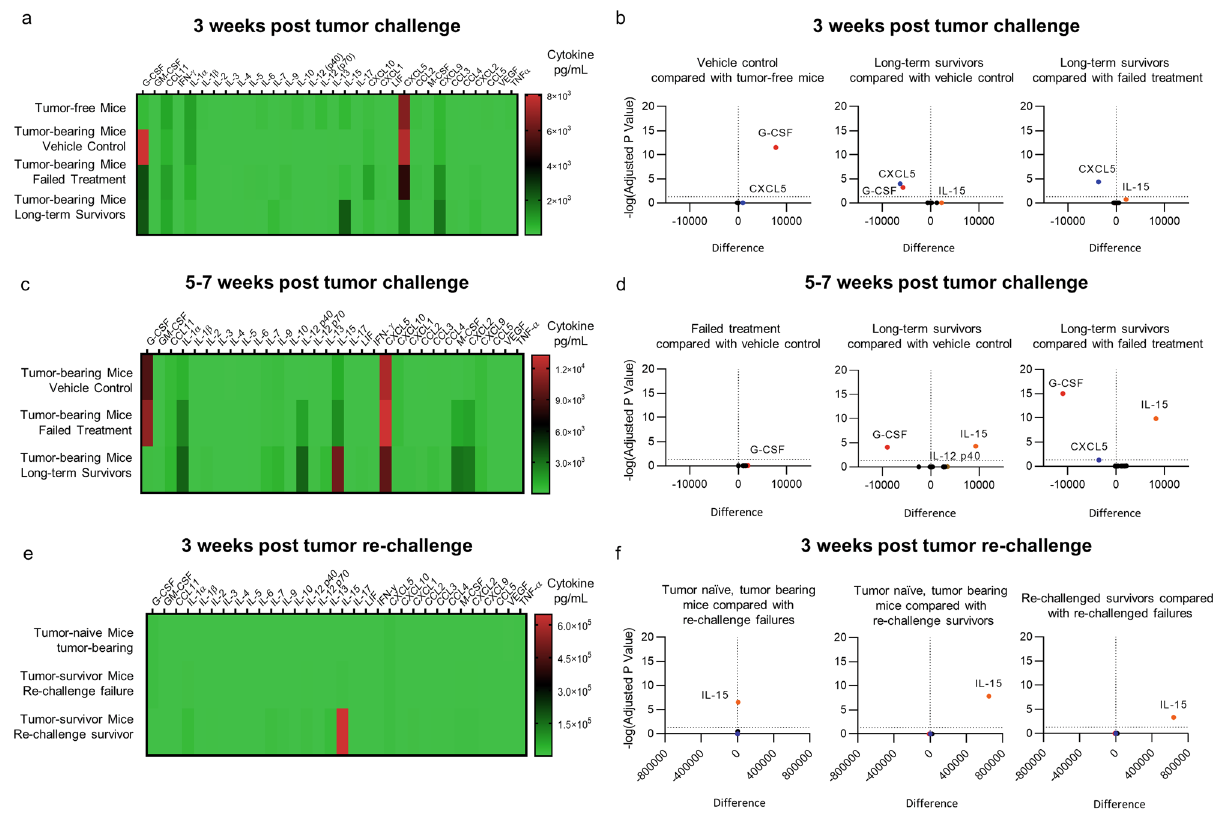
Fig. 4 Peripheral blood cytokine pro fi le in vivo. a Heatmap of 32 peripheral blood cytokines of tumor-free mice and mice challenged with 4T1 FUGW-FL tumors three weeks post orthotopic tumor implantation: tumor-free mice (healthy mice, no tumor implanted); tumor-bearing mice, vehicle (PBS) control (non-survivors), tumor-bearing mice, failed treatment (non-survivors), and tumor-bearing mice, long-term survivors. b Volcano plot highlighting detectable statistical difference between peripheral blood cytokines three weeks post orthotopic tumor challenge. c Heatmap of 32 peripheral blood cytokines of mice challenged with 4T1 FUGW-FL tumors 5 to 7 weeks post tumor implantation: tumor-bearing mice, vehicle (PBS) control (non-survivors) at week 5; tumor- bearing mice, failed treatment (non-survivors), weeks 5 to 7; and tumor-bearing mice, long-term survivors during weeks 6 and 7. d Volcano plot highlighting detectable statistical difference between peripheral blood cytokines taken between 5 and 7 weeks post orthotopic tumor challenge. e Heatmap of 32 peripheral blood cytokines of mice re-challenged with 4T1 FUGW-FL tumor: tumor naïve mice, tumor-bearing (non-survivors), tumor survivor mice, re-challenge failure (non-survivors) and tumor survivor mice, re-challenge survivor (long-term survivors) taken three weeks post orthotopic 4T1 FUGW-FL tumor implantation. f Volcano plot highlighting detectable statistical difference between peripheral blood-bourne cytokines taken three weeks post orthotopic tumor